Question: State the chart type depicted above.
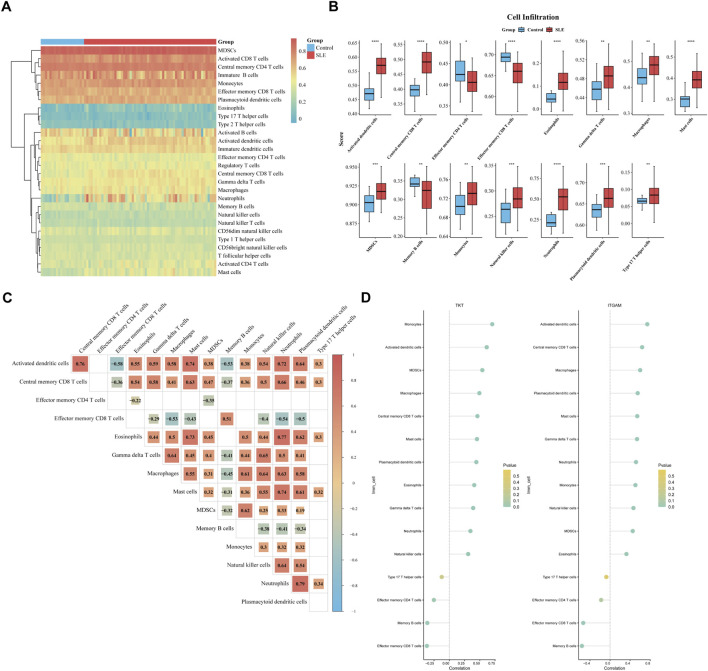
Answer: box